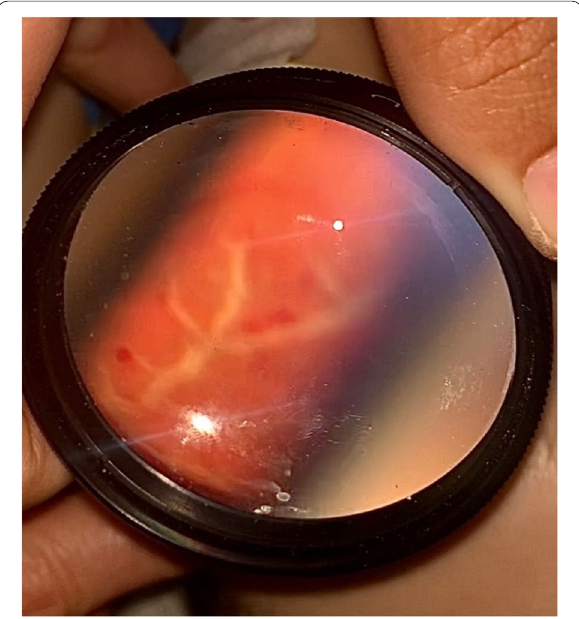
Fig. 2 Bedside indirect ophthalmoscopy of the left eye showing perivascular sheathing consistent with “frosted branch” angiitis, and retinal hemorrhages. Image has been inverted to focus on the superior